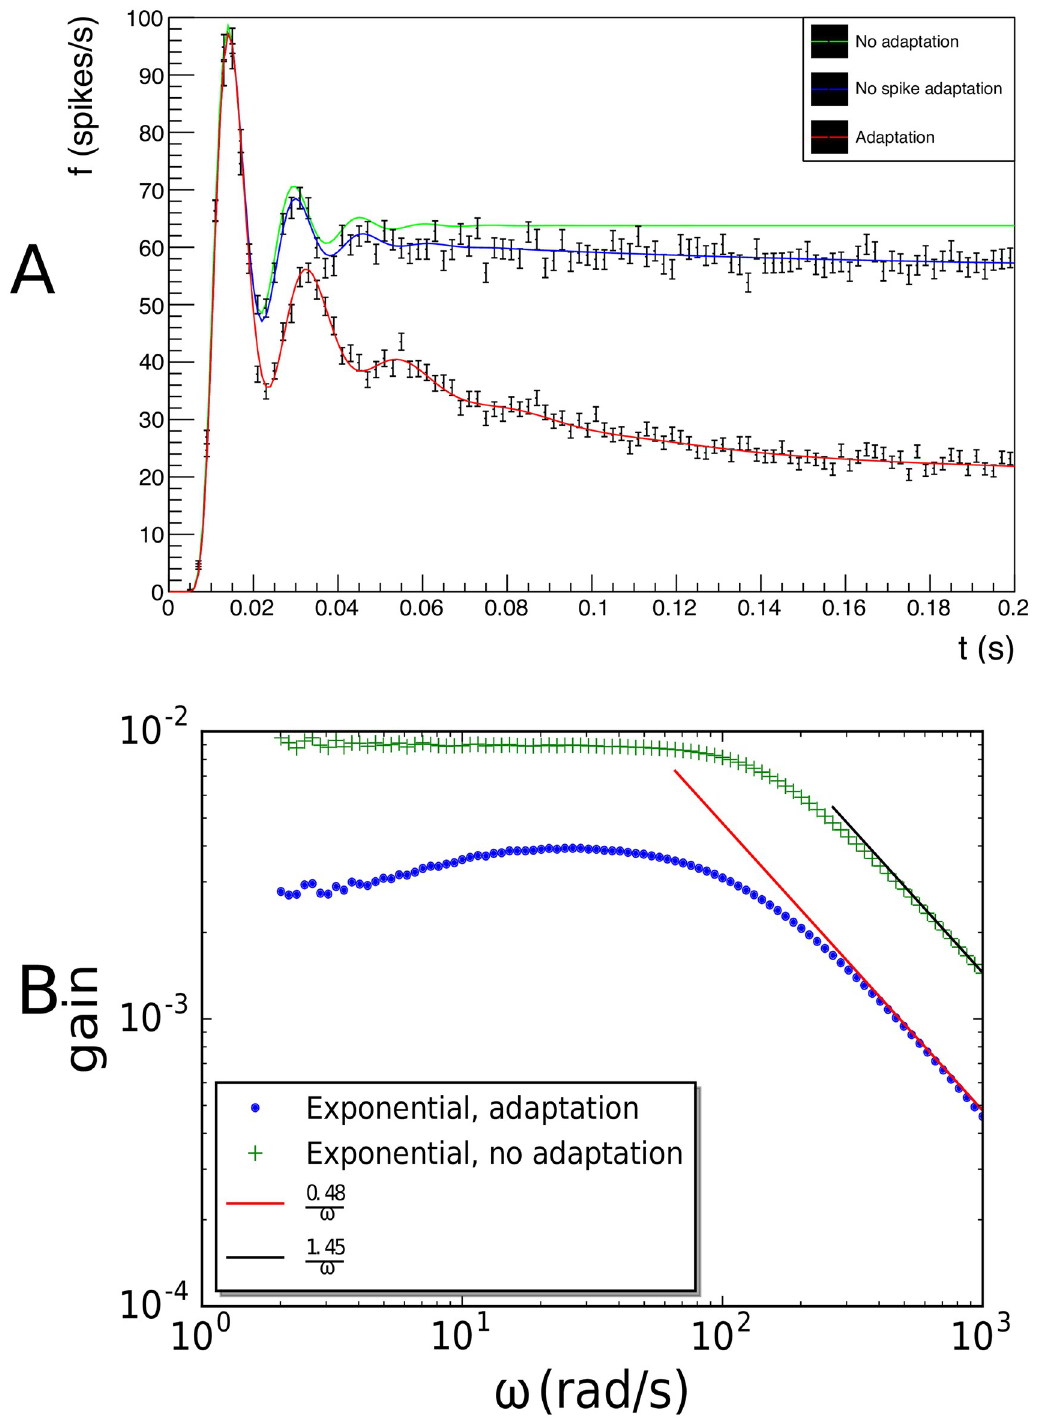
Fig 10. A: compares the response for three cases: no adaptation; only current adaptation; and both current- as well as spike- based adaptation is included. B: The gain for a small sinusoidal input modulated on a background input as function of frequency, for no adaptation and AdExp with current- and spike-based adaptation. Both spectra show the 1 exponential-integrate-and-fire neuron, as the spike shape, represented by the grid at high V values is independent of w . However, the numerical difference between the cases is vast.